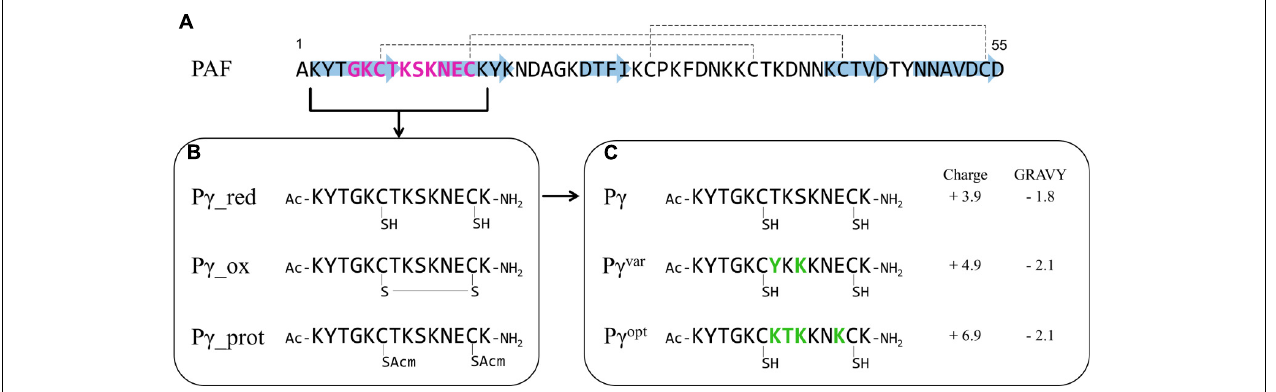
FIGURE 1 | Synthetic PAF γ -core peptides. (A) The primary structure of PAF with indicated β -strands (blue arrows) and disulfide bonds (dashed lines). The γ -core motif is highlighted in purple. (B) P γ peptide spanning the γ -core motif of PAF in different modifications: red – Cys in reduced form (–SH), ox – cyclic peptide with closed disulfide bonds (S–S), prot – Cys with a protecting group (SAcm). The sulfur (S) atom of the Cys is indicated. The N- and C-termini of the P γ peptides are acetylated (Ac) and amidated (NH 2 ), respectively. (C) The reduced P γ form and the derived peptide variants P γ var and P γ opt . Amino acid substitutions are highlighted in green, the net charge (at pH 7, http://protcalc.sourceforge.net) and GRAVY (www.gravy-calculator.de) are indicated.